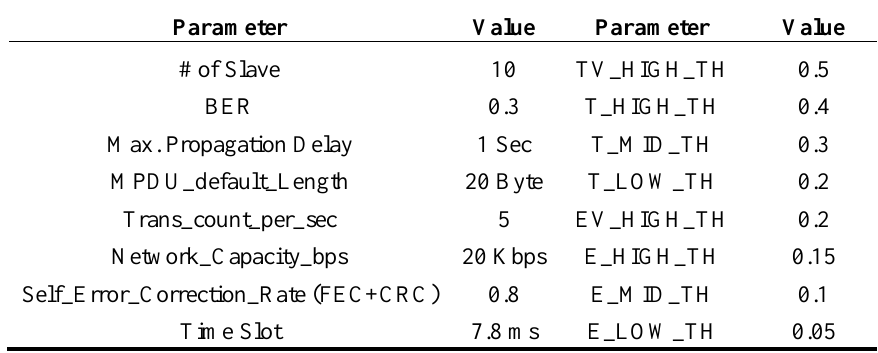
Table 1. Sample of UW-ASN system input parameter.